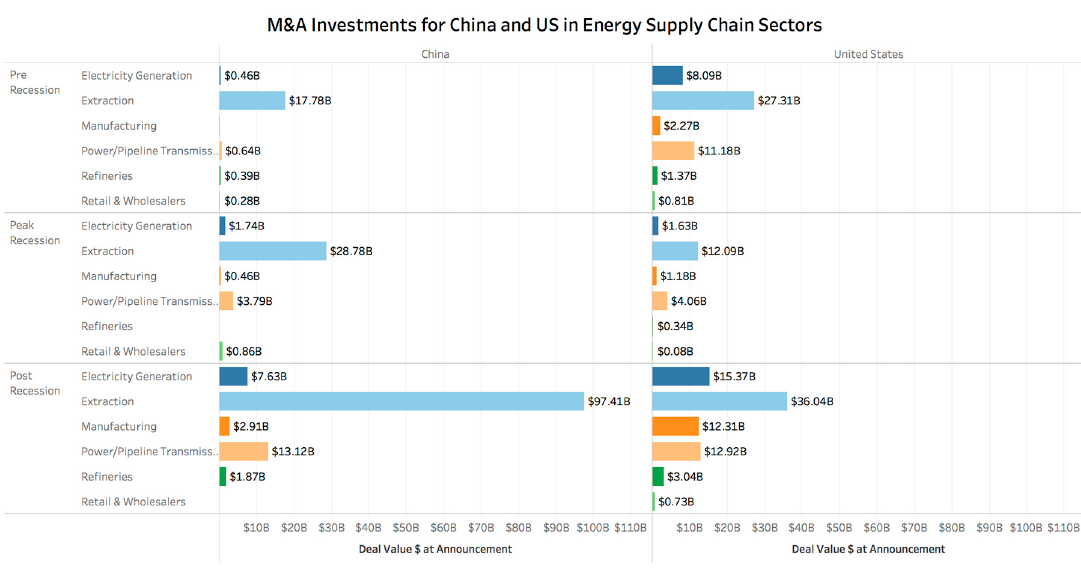
Figure 11. China & US—M&As in energy sector supply chain segments.